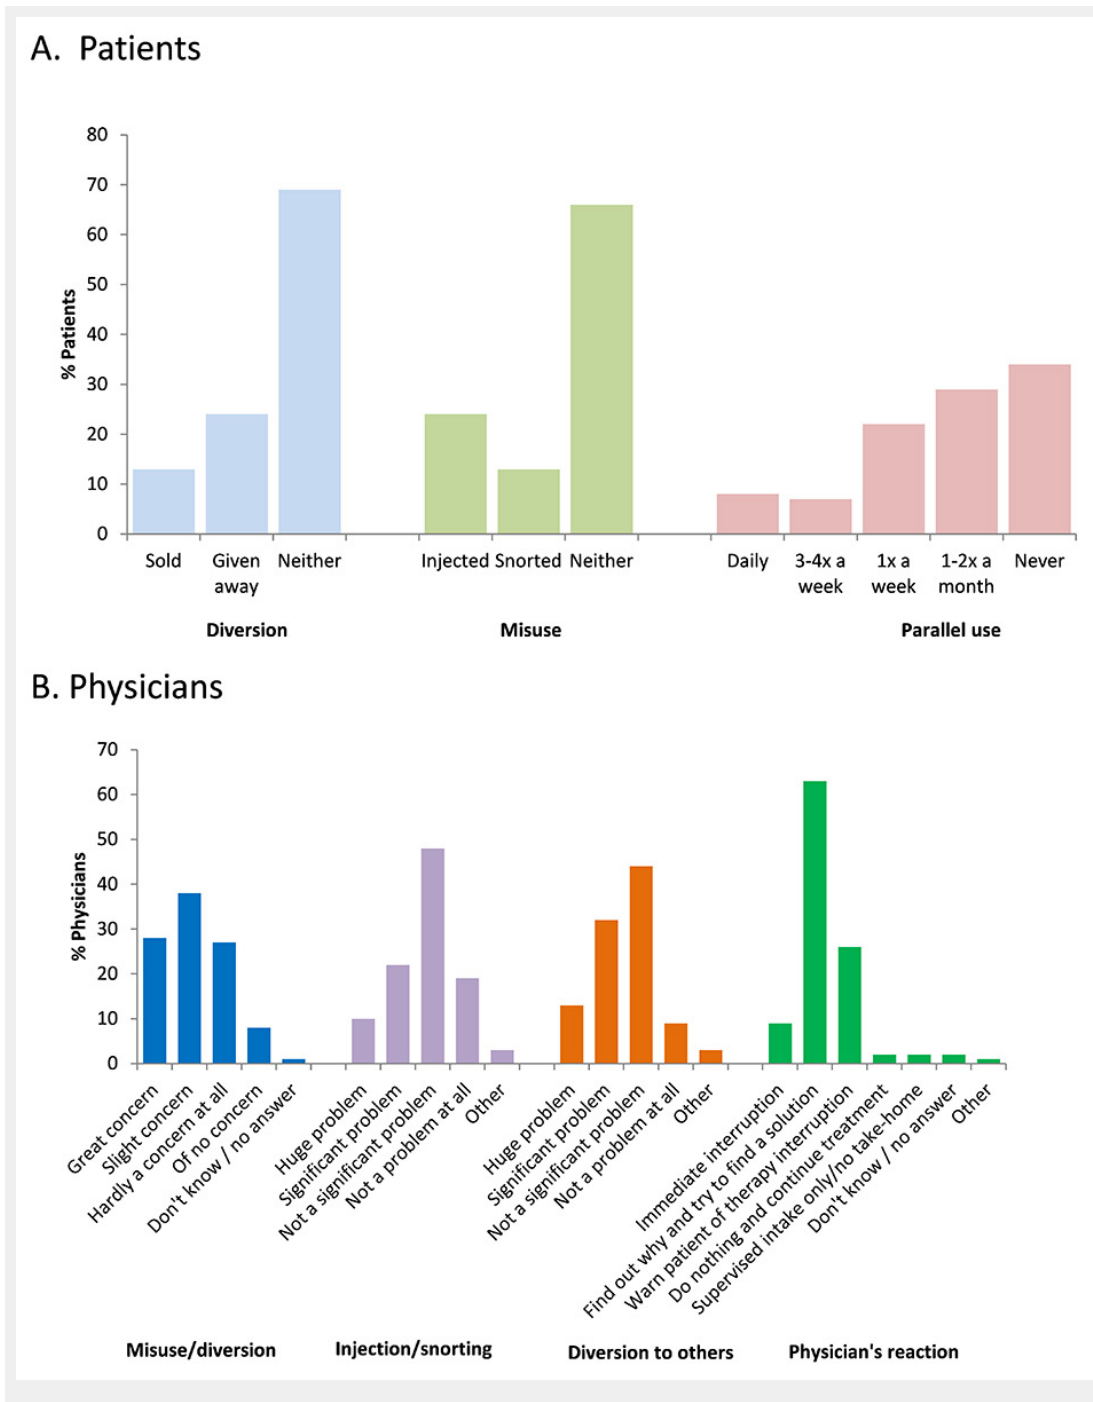
A summary of data on misuse, diversion and parallel use. A. Patient-reported data on the different ways of diversion, and misuse and the frequency of parallel consumption of illicit drugs. B. Physician-reported data on views about misuse and diversion and their reaction to these